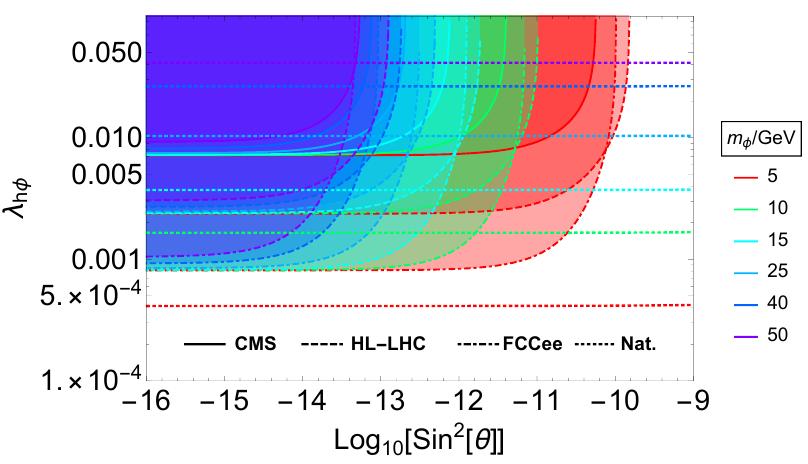
Figure 7 . Bounds on λ hφ and sin 2 θ for various singlet masses arising from searches for invisible Higgs decays. The dotted lines show the upper naturalness limit λ max a vertical asymptote, driven by the limit on BR